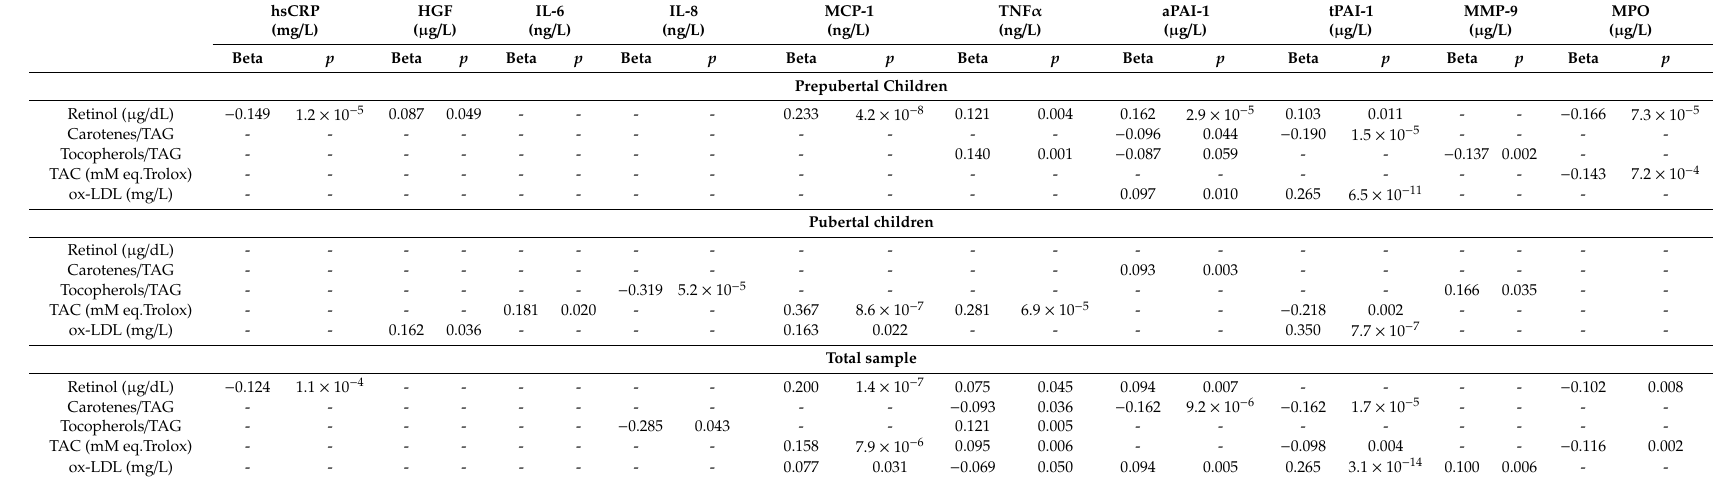
Table 5. Association of plasma antioxidants and oxidative stress biomarkers with pro-inflammatory and endothelial damage